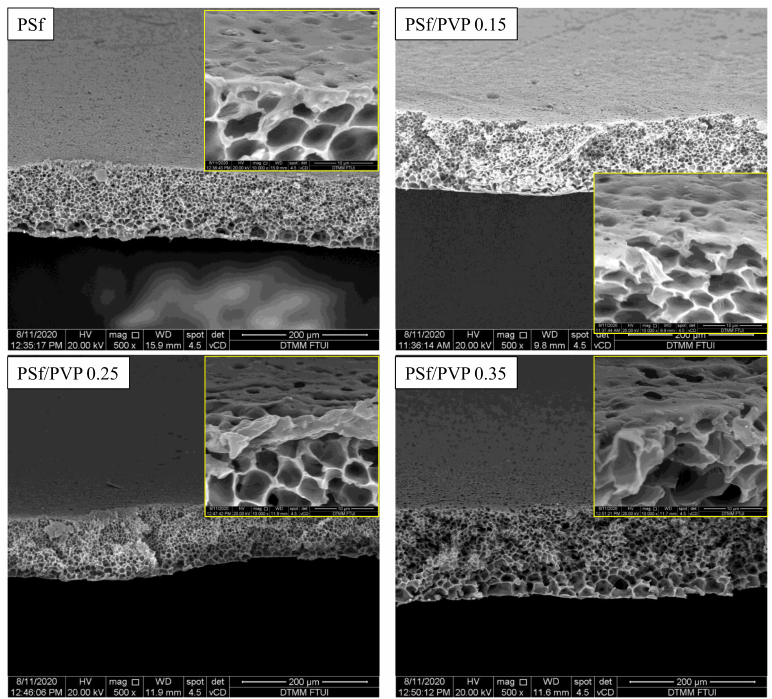
Figure 3. FESEM characterization of the cross sections of PSf, PSf/PVP 0.15, PSf/PVP 0.25, and PSf/PVP 0.35 membranes with a magnification of 500